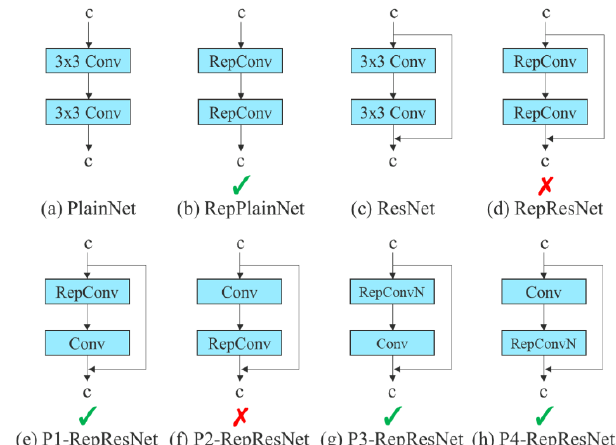
Figure 3. The YOLOv7 architecture, the planned re-parameterized version of RepConv. RepConv is replaced by RepConvN as RepConv does not have an identity connection [21].